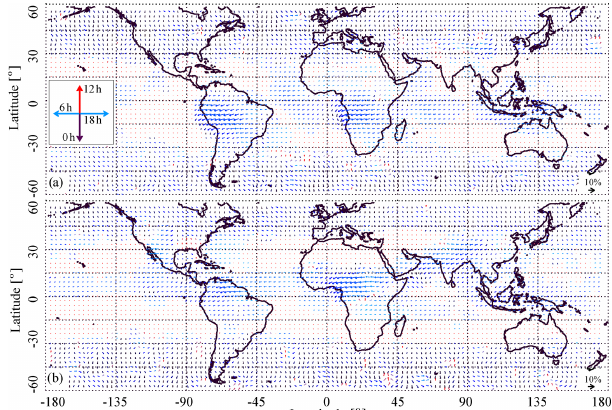
Figure 7. Diurnal variation of average relative humidity in a layer 150hPa below the tropopause, estimated from ERA-Interim reanal- yses, (a) for January and (b) for July. The vector representation is consistent with the caption of Fig. 5. The tropopause level was de- termined in accordance with Reichler et al. (2003).